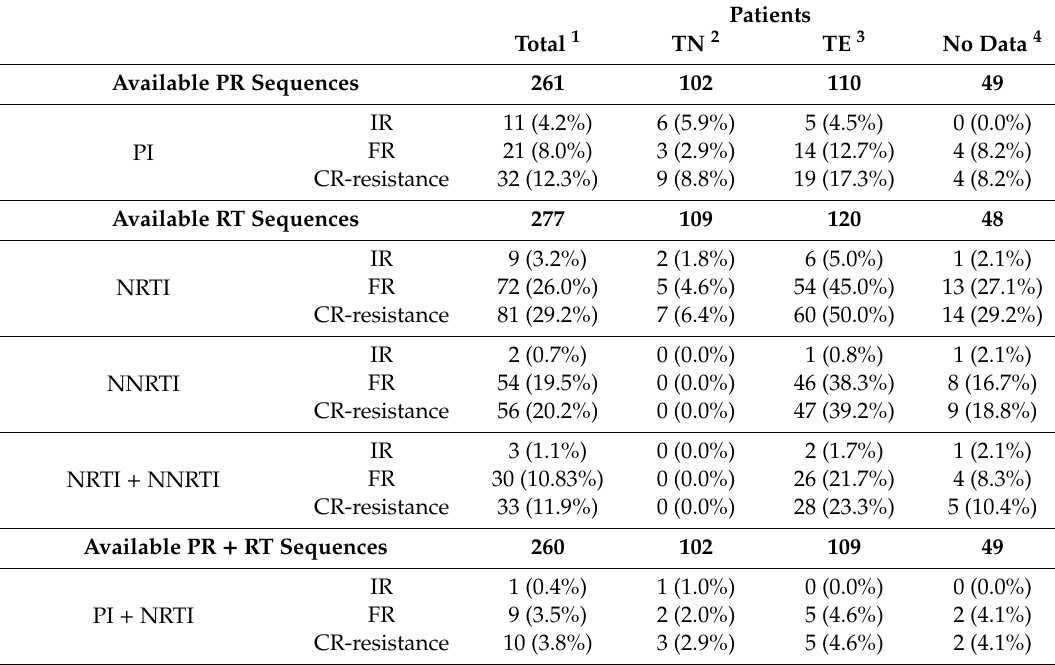
Table 2. Number of available sequences and drug